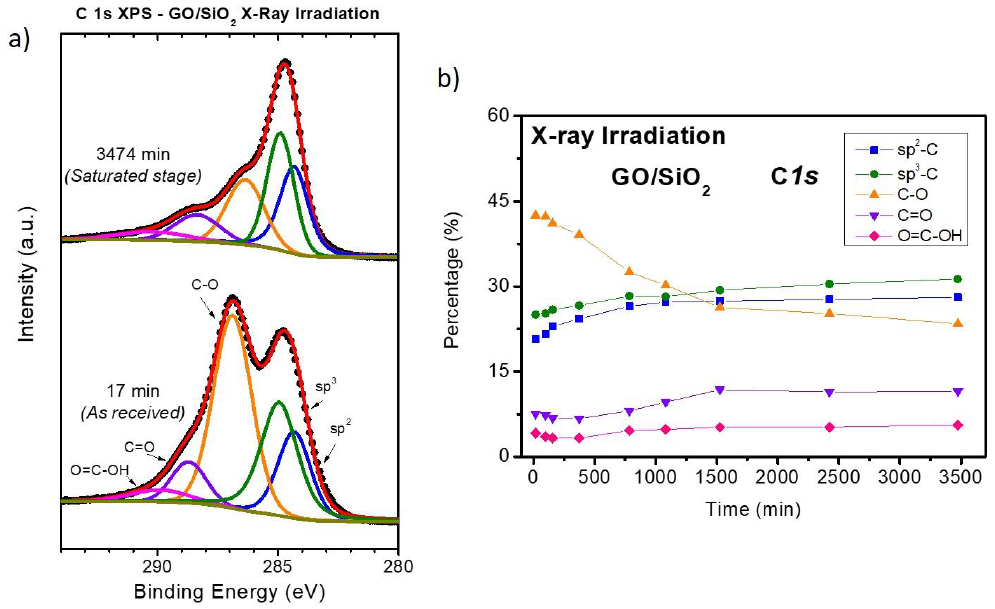
Figure 4. ( a ) Fitted XPS C 1s spectra of as received GO / SiO 2 (bottom) and GO / SiO 2 after 3474 min of X-ray irradiation (top). ( b ) Relative intensities of the XPS C 1s contributions used for the fitting in ( a ) as a function of irradiation time.